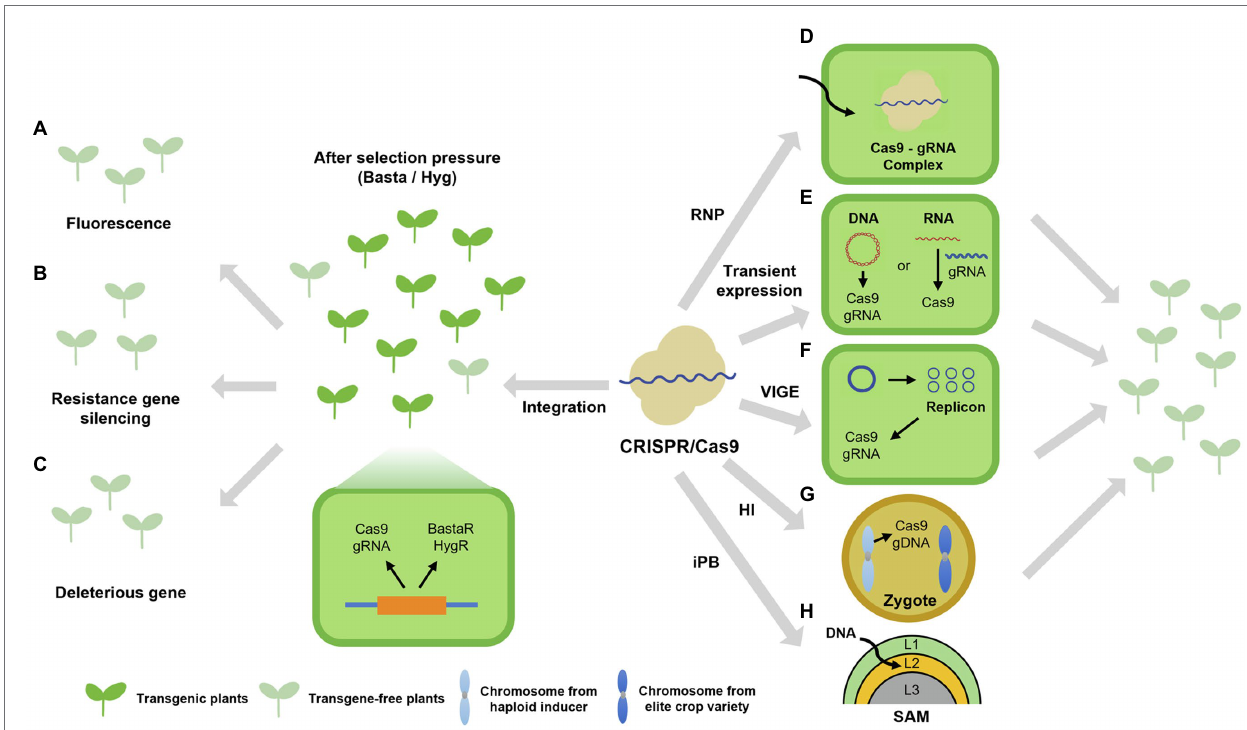
FIGURE 2 | Schematic overview of strategies for the generation and isolation of transgene-free edited plants. (A–C) Strategies for the isolation of transgene-free edited plants. The designed constructs encoding the CRISPR/Cas9 system and selection markers, such as fluorescent proteins in seeds (Gao et al., 2016; Stuttmann et al., 2021; A ), the hairpin RNA interference element silencing CYP81A6 and conferring sensitivity to the herbicide bentazon (Lu et al., 2017; B ), and deleterious genes (He et al., 2018; Stuttmann et al., 2021; C ), were separately introduced into plants by Agrobacterium-mediated transformation. The constructs integrate into the plant genome and express both Cas9 and the selection markers. After identification of edited plants, plants lacking the trait conferred by the selection marker can be isolated as transgene-free efficiently. (D–F) Strategies for the generation of edited plants without the stable integration of a transgene. Several CRISPR/Cas9 systems allow gene editing without requiring the stable integration of a transgene. Preassembly of a ribonucleoprotein containing purified Cas9 and in vitro transcribed sgRNA (Woo et al., 2015; Malnoy et al., 2016; Subburaj et al., 2016; Svitashev et al., 2016; Liang et al., 2017; Andersson et al., 2018; Toda et al., 2019; Nicolia et al., 2021; D ); transient expression system based on CRISPR/Cas9 DNA or RNA (Zhang et al., 2016; Chen et al., 2018; E ); and viral vectors designed for CRISPR/Cas9 (Oh et al., 2021; F ). (G) Transgene-free genome editing based on haploid induction. Crossing a haploid inducer line carrying the CRISPR/Cas9 transgene ( Cas9 and sgRNA) with the wild-type (WT) plant produces zygotes with one chromosome derived from the haploid inducer line and one chromosome derived from the WT. Since the chromosomes from the haploid inducer line are later eliminated, so is the transgene expressing Cas9 and the sgRNA, leaving only edited chromosomes derived from the WT; diploid transgene-free edited plants can then be obtained by diploid induction. (H) The in planta genome editing based on in planta particle bombardment (iPB) method. Biolistic delivery of plasmids expressing CRISPR/Cas9 system into the L2 cell layer of shoot apical meristem (SAM) generates stable transgenic wheat lines without callus culture and regeneration (Hamada et al., 2018; Liu et al.,